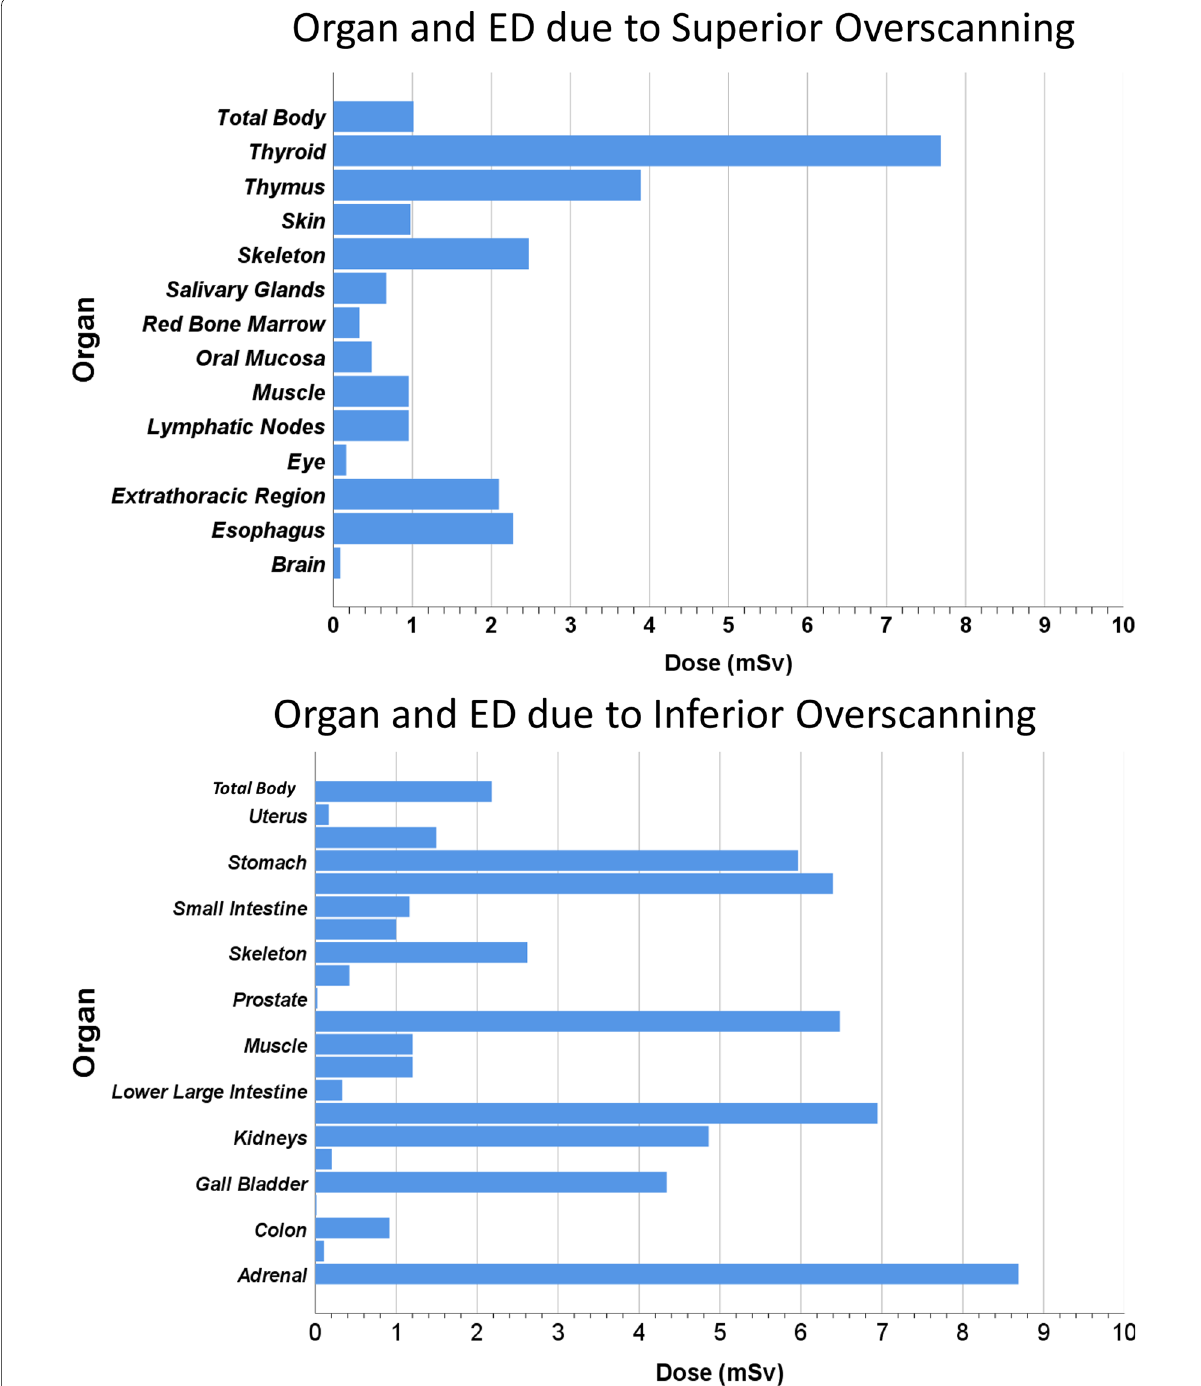
Fig. 3 Additional radiation dose in terms for selected organs (in mGy) and effective dose (in mSv) due to overscanning in superior (left) and inferior